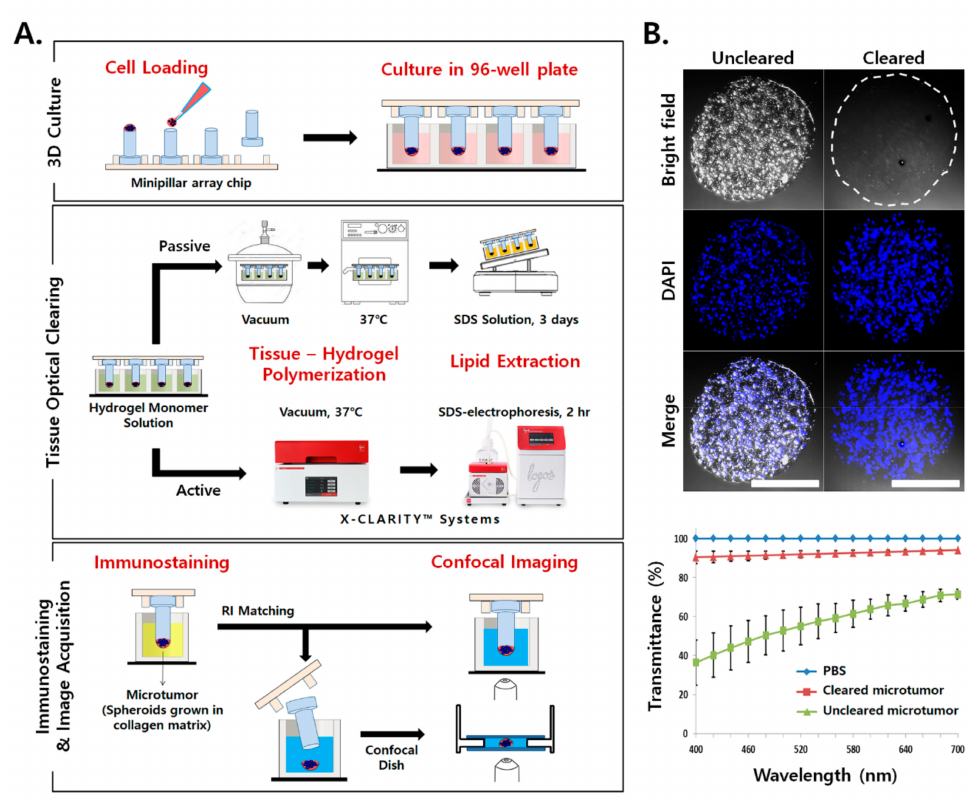
Figure 1. Three dimensional (3D) culture and tissue optical clearing (TOC) of microtumors grown on a minipillar array chip. ( A ) Cancer cells suspended in collagen solution were loaded onto minipillars and cultured to grow microtumors in a 96-well plate. Tissue clearing was achieved by polymerization of a tissue-hydrogel followed by sodium dodecyl sulfate–based lipid extraction using the CLARITY method [23]. A commercial X-CLARITY ™ system was used for the active process. Confocal imaging of the microtumor in a 96-well plate or on a confocal dish after sample transfer was performed following immunostaining and refractive index matching. ( B ) Improved light transmittance by TOC was confirmed in microtumors stained with DAPI. Data represent the mean ± SD of three independent experiments. Scale bars, 1